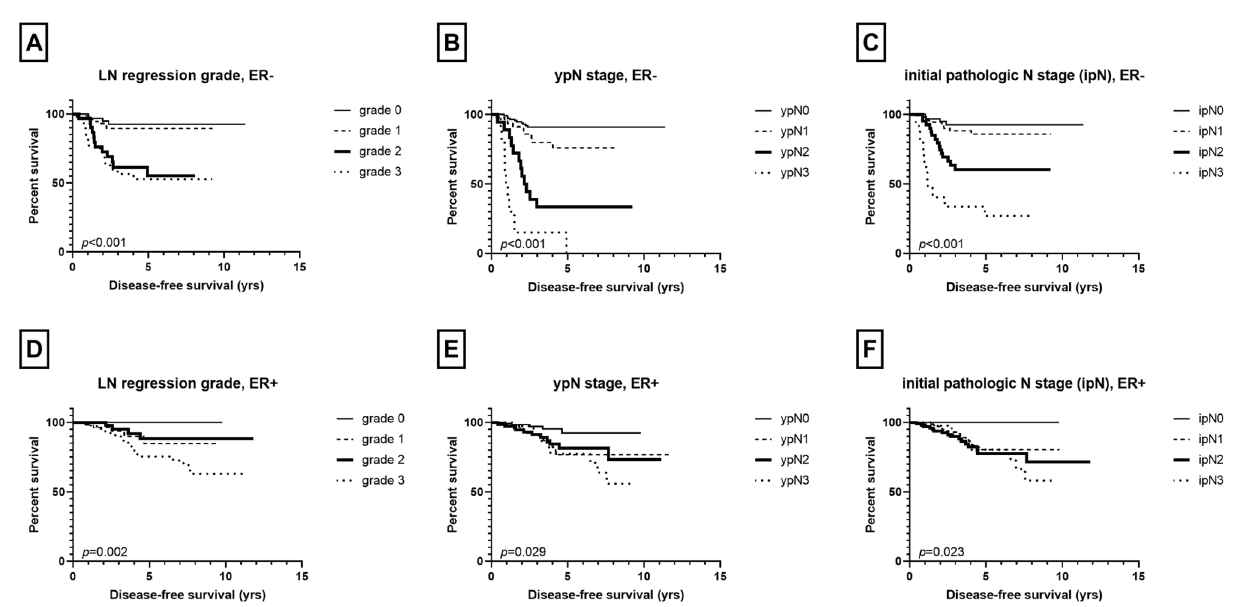
Figure 3. Disease-free survival based on lymph node (LN) status after neoadjuvant chemotherapy by estrogen receptor (ER) status. In ER-negative subgroup, significant survival difference is observed based on LN regression grade (A) , ypN stage (B) , and initial pathologic N (ipN) stage (C) , while in ER-positive subgroup, LN regression grade (D) , ypN stage (E) , and ipN stage (F) show less significant associations with patients’